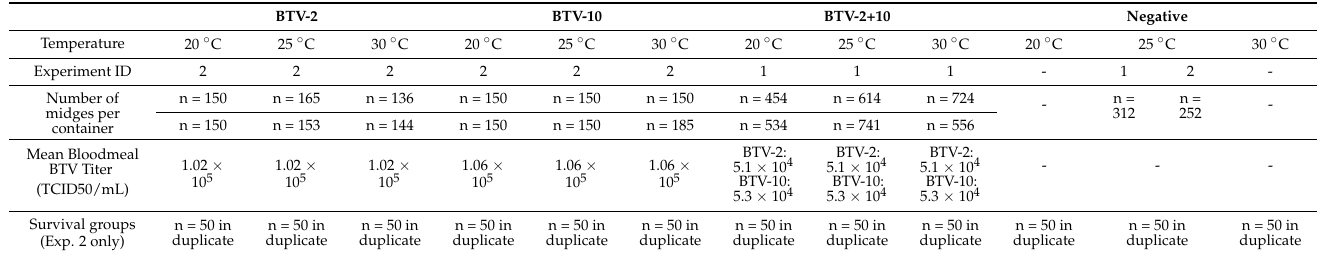
Table 1. Groups of C. sonorensis exposed to BTV in Experiments 1 and